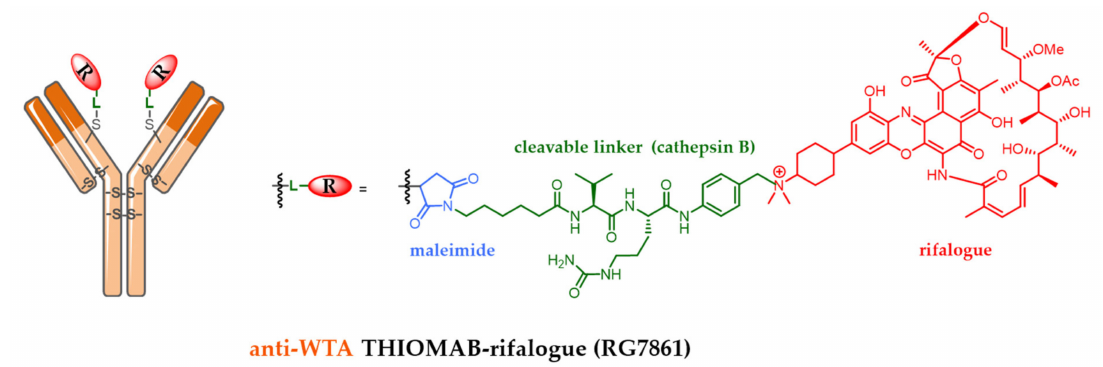
Figure 19. RG7861 formula, ADC with a DAR 2, resulting from the site-specific conjugation of rifalogue onto an anti-wall-teichoic acid (WTA) Thiomab via a cathepsine B-sensitive linker, targeting the surface of Staphylococcus aureus